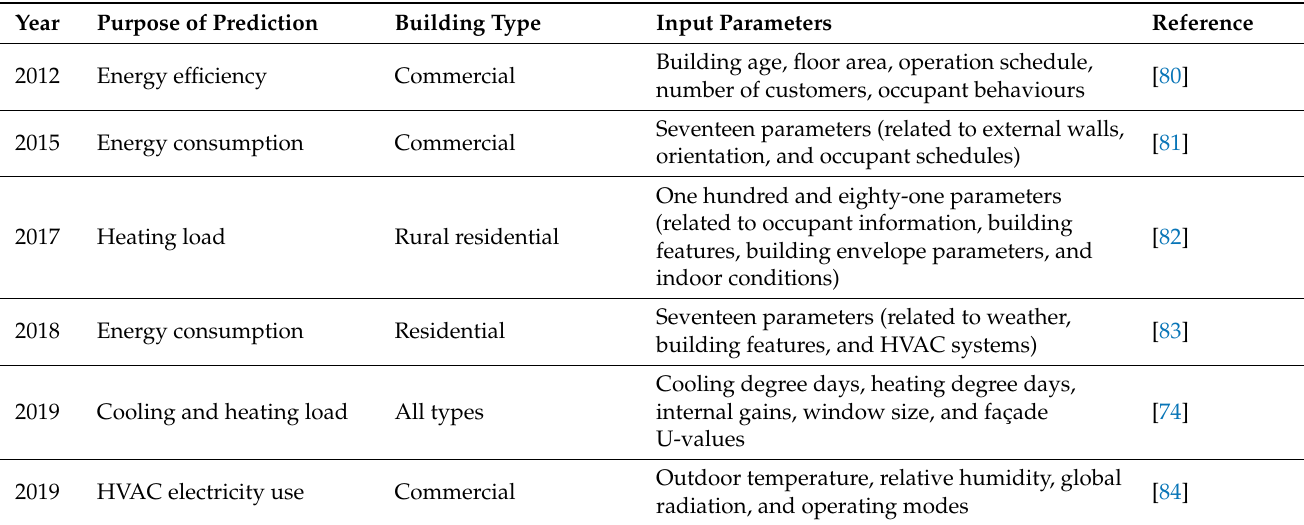
Table 2. Studies related to MLR